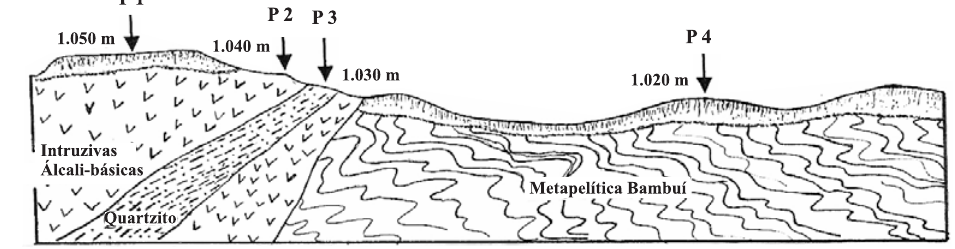
Figura 1. Perfil geológico esquemático da topolitossequência Serra do Salitre (T1) e posições dos respectivos solos.